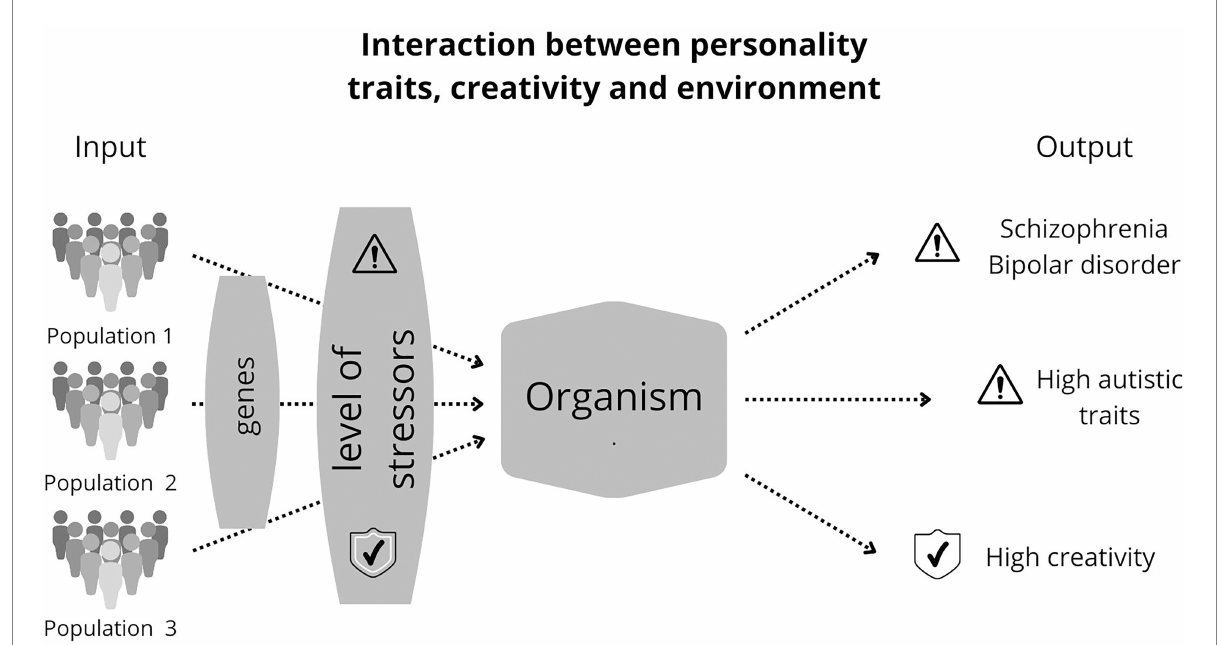
FIGURE 2 Consequences of stress on people with schizotypal and autistic traits. Creative people are moderately schizotypal. In other words, schizotypal people are often imaginative, associating ideas in unusual ways. People with schizophrenia and bipolar disorder also have these characteristics, sometimes manifesting them in a “dysfunctional way,” e.g., in a paranoid way, but not in an artistic way. That “dysfunctional manifestation” of creativity can occur because of stressors that disrupt normal nervous system development. Thus, individuals with the same genetic propensities for high creativity may manifest it in the form of a disorder or the neurotypical form, depending on how much the stressors have affected ontogeny. This figure shows three examples of populations, each subjected to different levels of environmental stress. The symbol with “!” means high levels of stressors, while the symbol “ok” means tolerable levels of stressors, that is, those that do not significantly impair neural